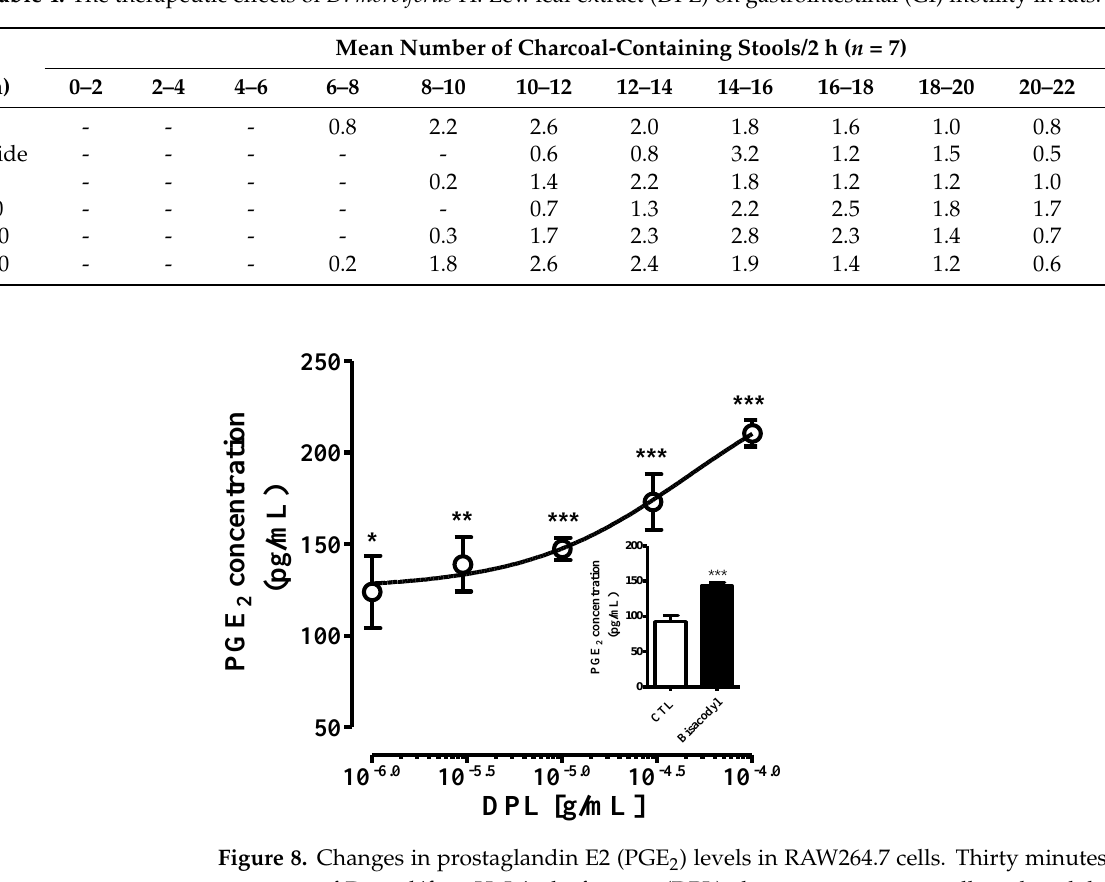
Table 3. The preventive effects of D. morbiferus H. L é v. leaf extract (DPL) on gastrointestinal (GI) motility in rats. Mean Number of Charcoal-Containing Stools/2 h ( n = 7)